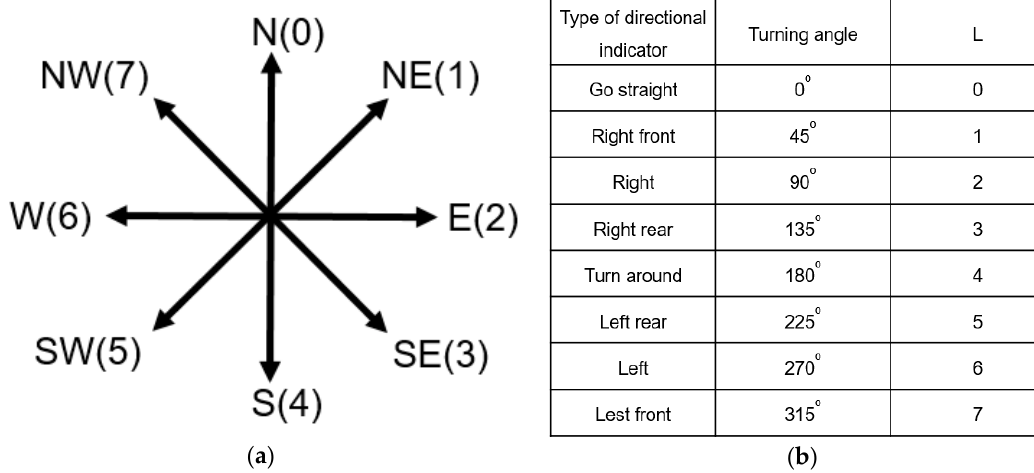
Figure 7. The definition of orientation and directional indicators. ( a ) R values; ( b ) L values.